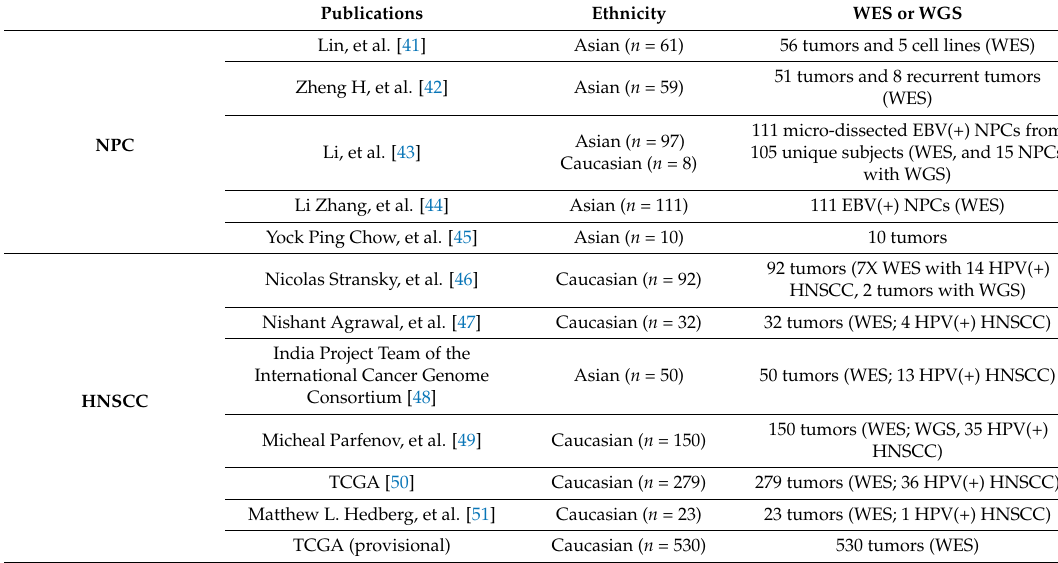
Table 2. WES or WGS studies for NPC and